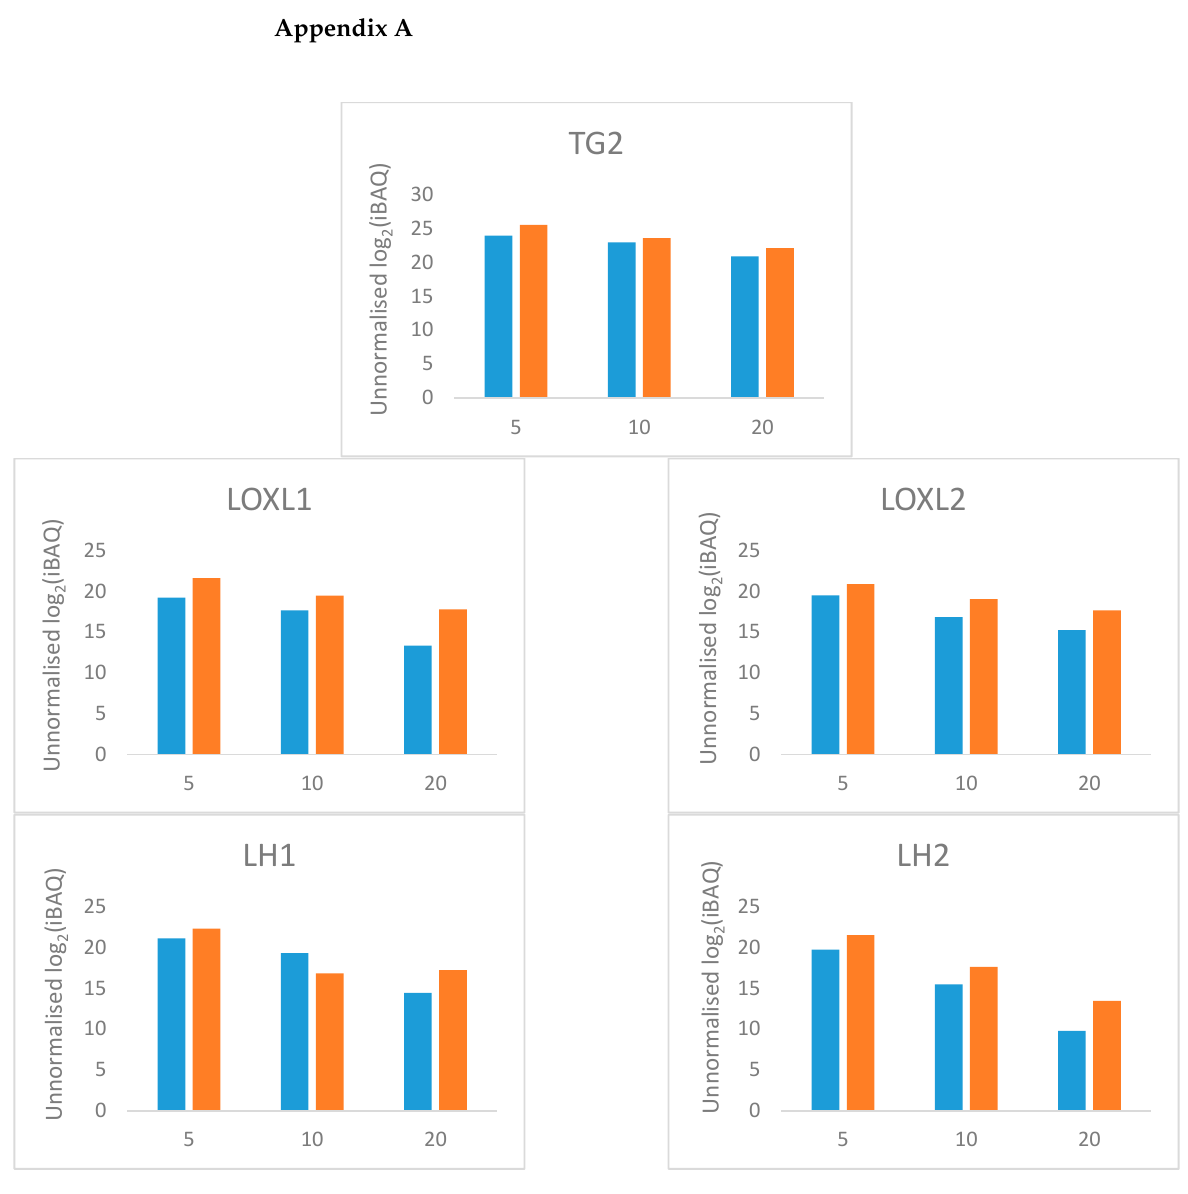
Figure A1. Time course of unnormalized cross-linking enzyme levels in the ECM during sustained stimulation of dermal fibroblasts with TGF β -1. The selected protein levels were obtained from a pilot time course experiment that analysed the ECM proteome during sustained TGF β -1 stimulation of dermal fibroblasts ( n = 1). The blue and the orange bars represent the protein amounts in the control and in the TGF β -treated samples, respectively.